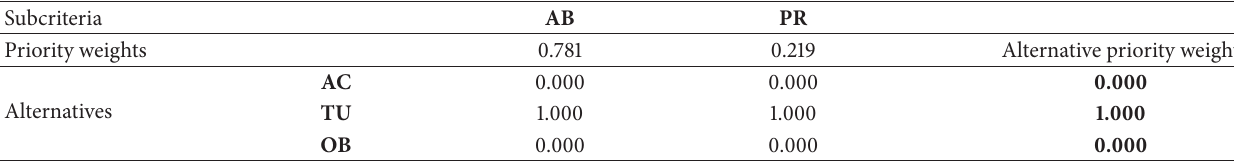
Table 8: Summary combination of priority weights: subcriteria of cost.